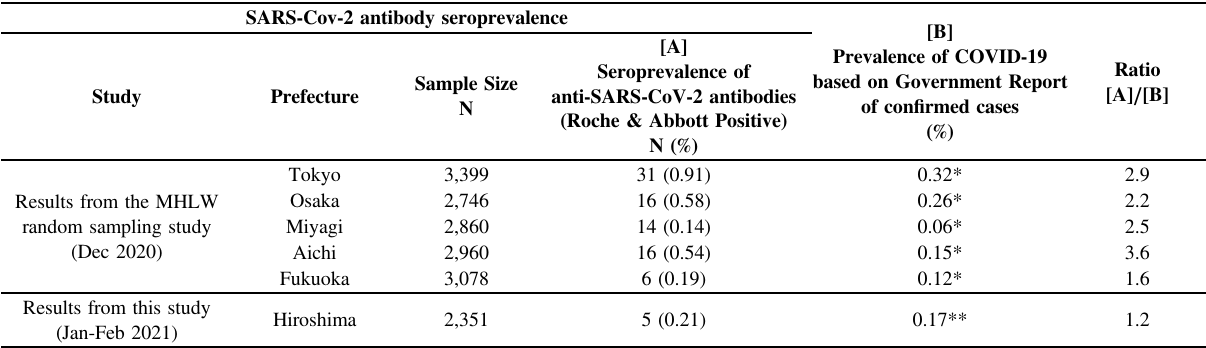
Table 3 Comparison of anti-SARS-Cov-2 antibody seroprevalence and the prevalence of con fi rmed COVID-19 cases in fi ve prefectures SARS-Cov-2 antibody